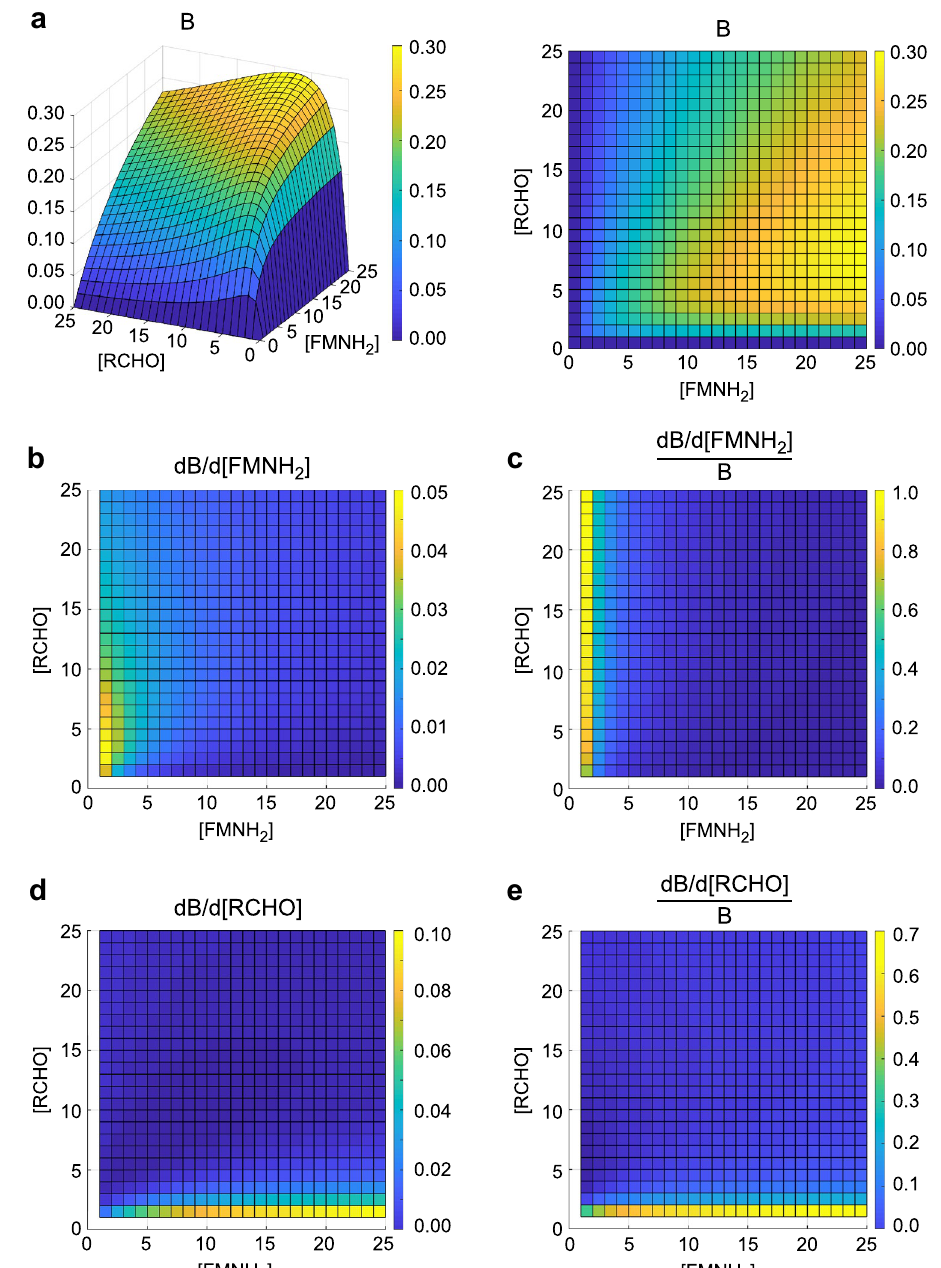
Figure 2. Qualitative model of the bioluminescence signal. (a) Bioluminescence signal B as a function of the concentrations of the substrates RCHO (aldehyde) and FMNH 2 . B was calculated based on the reaction scheme in Fig. 1 by setting all rate constants and the concentrations of luciferase and oxygen to 1. Left: side view, right: top view. ( b ) Derivative of the bioluminescence signal B with respect to the concentration of FMNH 2 , plotted as a function of the substrate concentrations. ( c ) Derivative of B with respect to the concentration of FMNH 2 , normalized to B. ( d ) Derivative of B with respect to the concentration of RCHO. ( e ) Derivative of B with respect to the concentration of RCHO, normalized to B. High values in ( c ) and ( e ) represent large relative changes of the bioluminescence signal with the respective substrate concentration and therefore optimal conditions for screening. Values are represented by their color as indicated in the colorbar in arbitrary